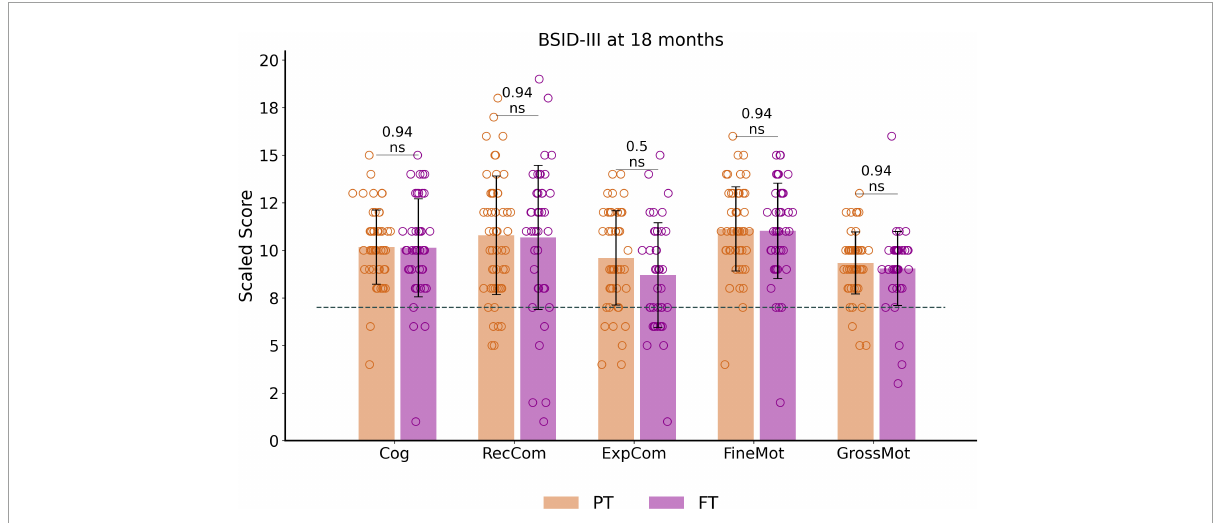
FIGURE2 Outcome assessment at around 18 months of corrected age: BSID-III scaled scores distribution and comparisons between preterm and full-term infant groups. The dotted line corresponds to the pathological threshold, with scores < 7 ( < -1 SD) indicating a developmental delay. Of note, only one extreme PT (male, born at 27.6wGA) presented severe developmental delay (scores < -3SD) for cognitive and both communication scores (with fine motor score at –2SD and gross motor score on the norm values). Reported p -values come from t -tests corrected for multiple comparisons. See Supplementary Figure 1 for infant subgroup analysis using one-way ANOVA. BSID-III, Bayley Scales of Infant and Toddler Development, Third edition. PT, preterm; FT, full-term. Cog, cognitive; RecCom, receptive communication; ExpCom, expressive communication; FineMot, fine motor; GrossMot, gross motor scaled scores; ns,